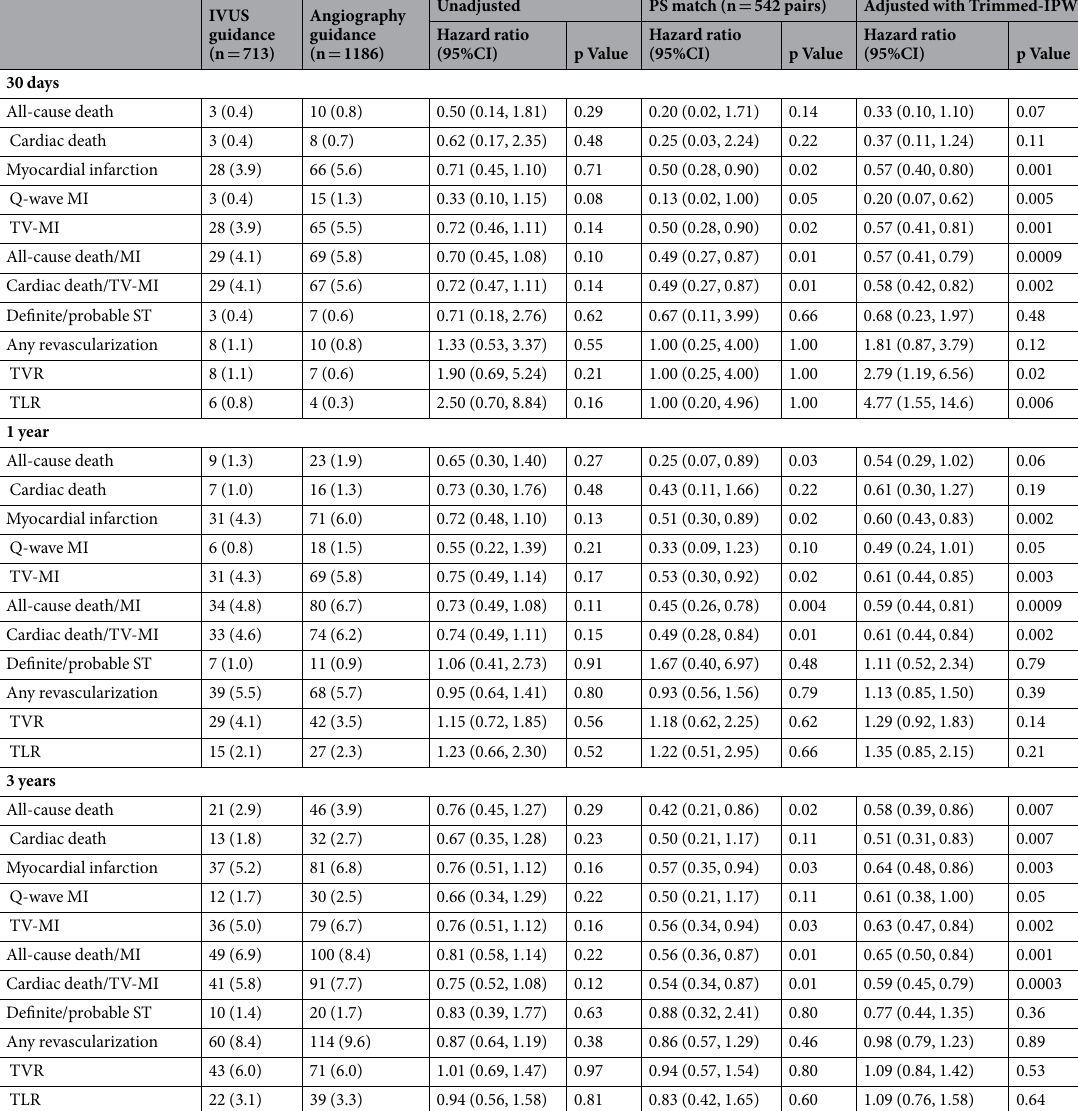
Table 3. Clinical Outcomes Through 3 Years. Values are mean ± SD or n (%). CI = confidence